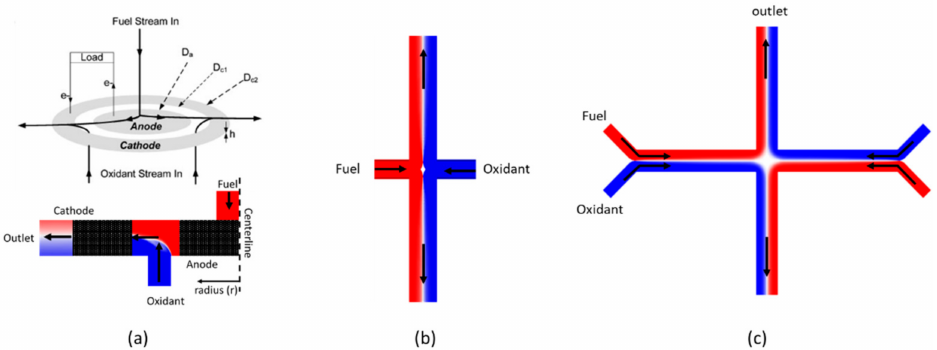
Figure 9. RFMMFCs: ( a ) sequential RFMMFC (reprinted from ref. [35]. Copyright 2008 Elsevier), ( b ) RFMMFC with flow-over type electrodes, and ( c ) combined CLFMMFC and